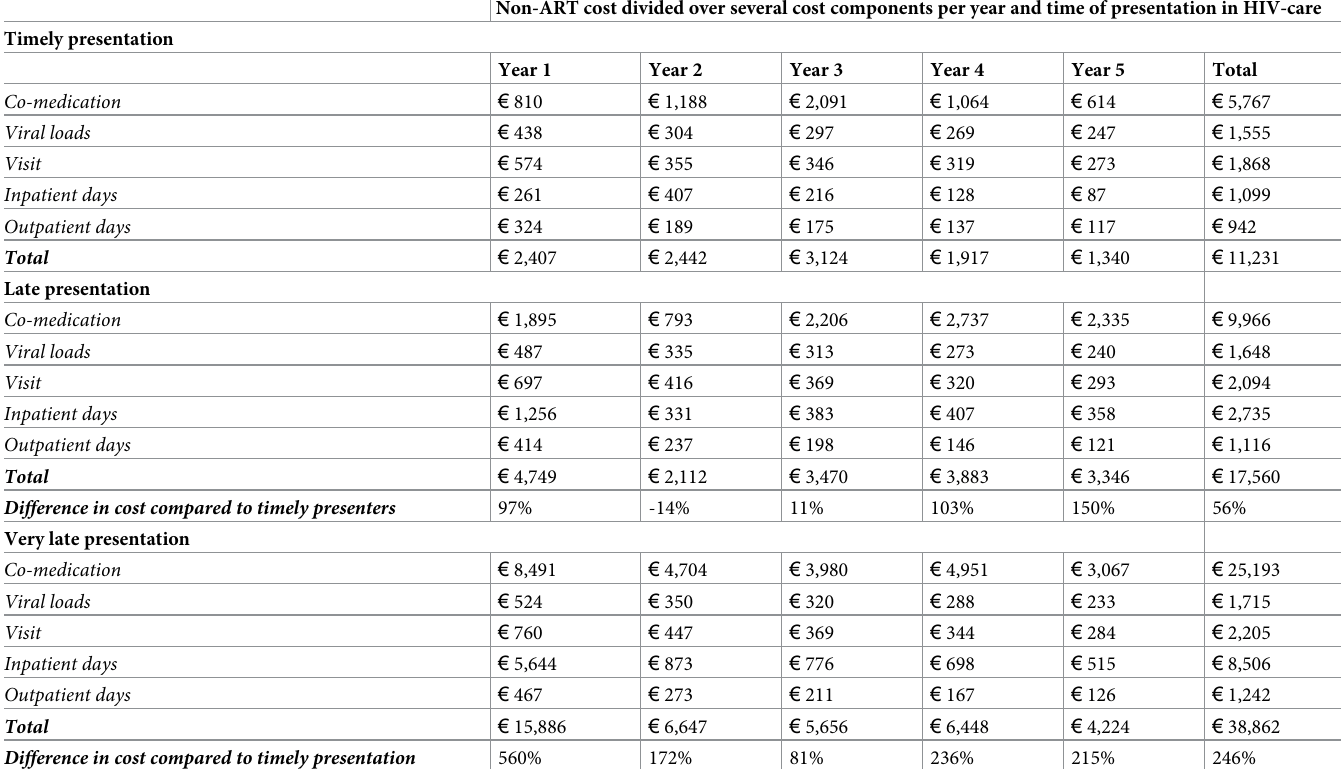
Table 3. Non-ART costs, by resource component and years after ART initiation divided by time of presentation in HIV-care. Non-ART cost divided over several cost components per year and time of presentation in HIV-care Timely